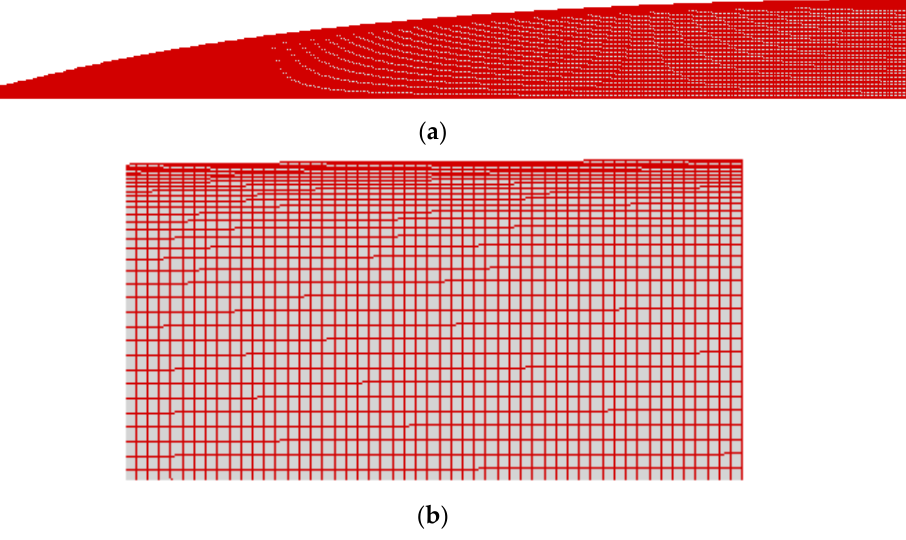
Figure 2. Grid diagram ( a ) and enlarged grid diagram near the wall ( b ).